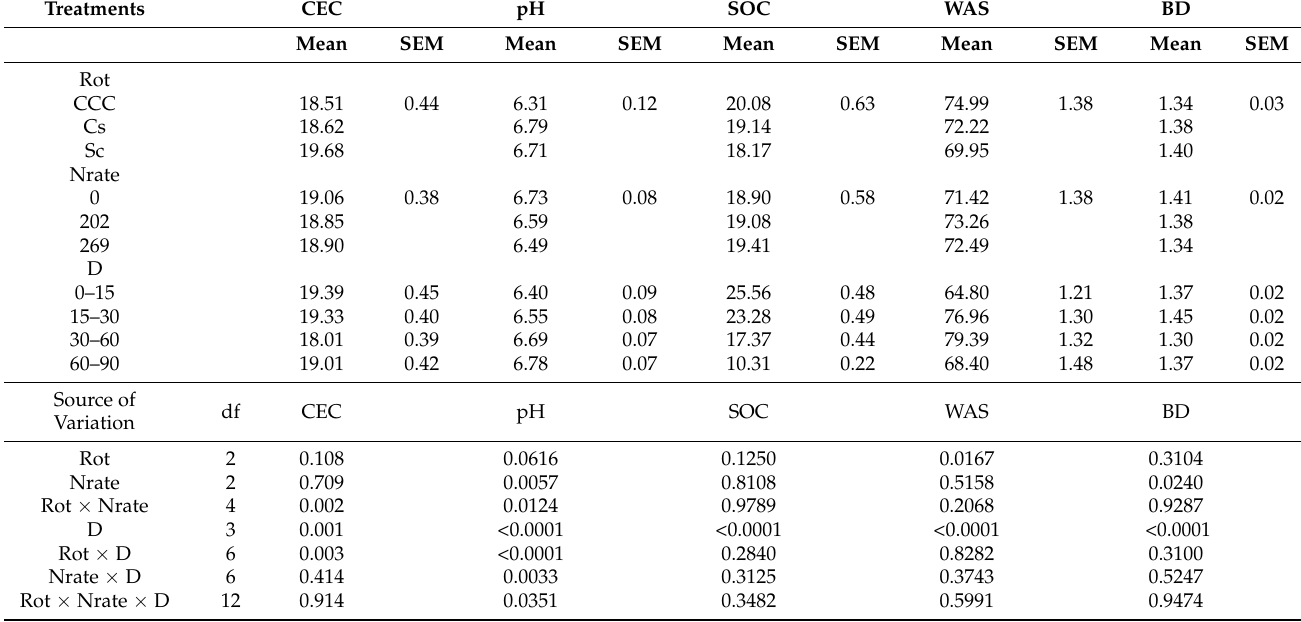
Table 1. The treatment mean values (Mean) and standard error of the means (SEM) of the soil properties: cation exchange capacity (CEC, cmol c kg − 1 ), soil pH, soil organic matter (SOC, g kg − 1 ), water aggregate stability (WAS, %), and bulk density (BD, Mg m − 3 ) determined by the main effects of crop rotation [Rot, continuous CCC; corn phase of corn-soybean rotation (Cs), and soybean phase of corn-soybean rotation (Sc)], N fertilization rate (Nrate, 0, 202, and 269 in kg N ha − 1 ), and soil depth (D, cm). Probability values ( p -values) and degrees of freedom (df) associated with the different sources of variation in the analysis of variance are shown